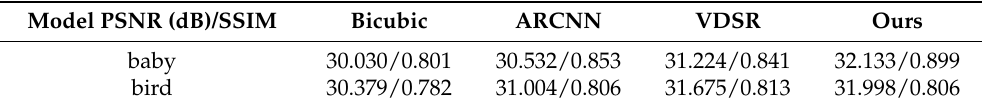
Table 2. Comparison of the results on PSNR and SSIM in Baby and